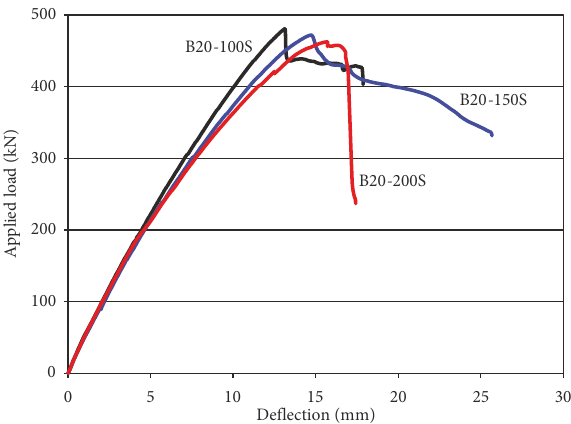
Figure 5. Load-deflection relationship for the test beams